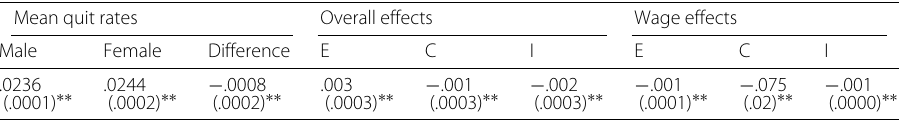
Table 5 Oaxaca decomposition of quit rates, summary of results Mean quit rates Overall effects Wage